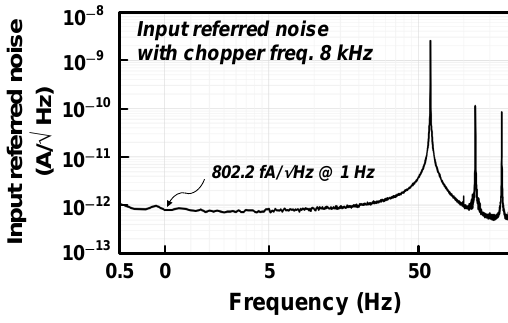
Figure 12. Input-referred current noise. Table 4. Comparison of performance with previous studies.